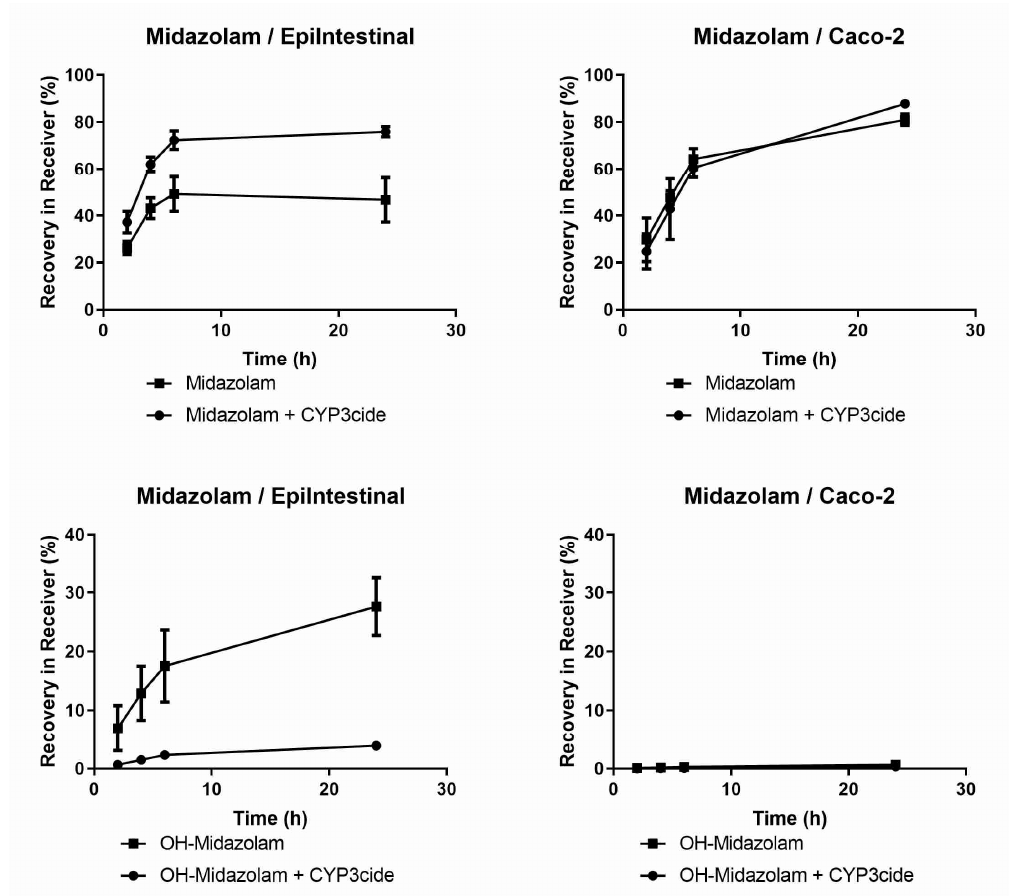
Figure 1. Apical-to-basal transport of midazolam in EpiIntestinal microtissues and Caco-2 cells. Midazolam (10 µM) was added to the apical compartment of EpiIntestinal microtissues (left panels) or Caco-2 cells (right panels) grown on Transwell inserts and incubated at 37 °C. At the time points as indicated, samples were taken from the basal (receiver) compartment. Midazolam (upper panels) and 1-Hydroxymidazolam (lower panels) were quantified in the samples via HPLC-MS/MS. The incubation was carried out in the absence or in the presence of the selective covalent CYP3A inhibitor CYP3acide (1 µM). Data are shown as mean values of triplicates. Error bars show standard deviations.